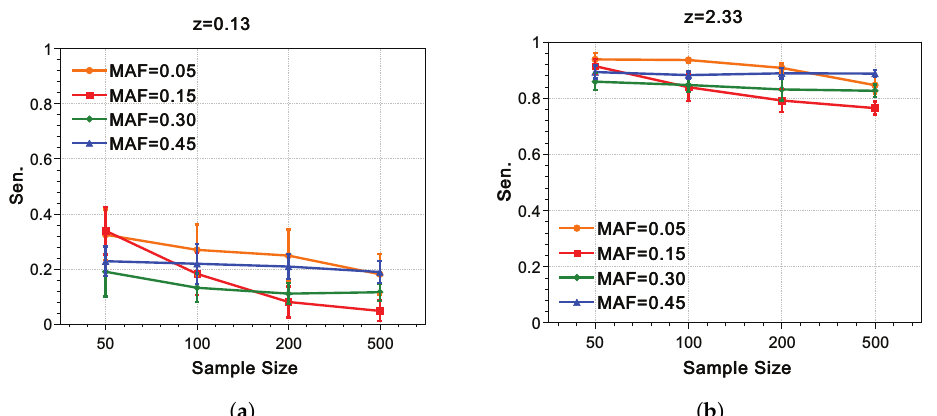
Figure 8. Sensitivity score Sen with SNP size m = 50 . The sample sizes n as 50, 100, 200, and 500 are expressed on the abscissa, respectively, while the matching accuracy is expressed on the ordinate. Matching accuracy with different MAFs and their standard deviations are expressed as different colored symbols with error bars, while the orange ellipse, red rectangle, olive diamond and blue triangle represent the MAF value of 0.05, 0.15, 0.30 and 0.45, respectively. ( a , b ) indicate z of 0.13 and 2.33, respectively. ( a ) z = 0.13. ( b ) z =